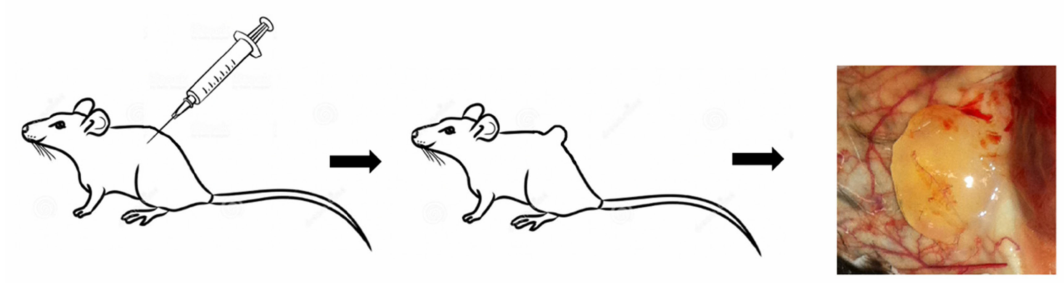
Figure 6. Matrigel plug in the flank of a mouse.